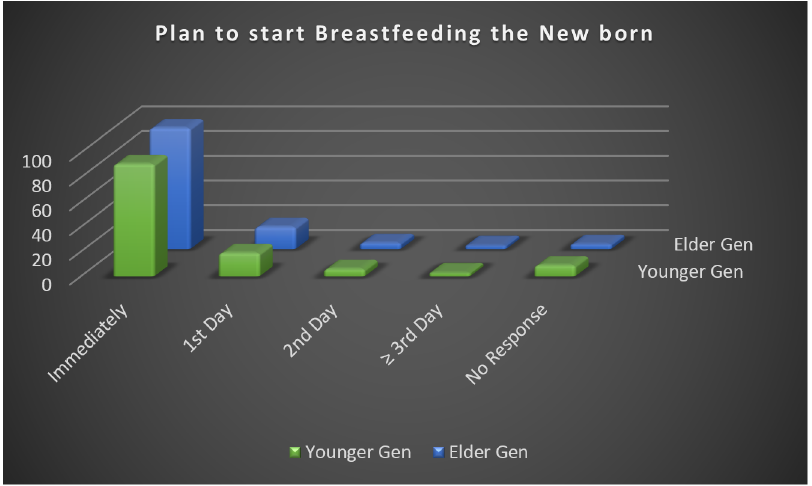
Fig 2. Responses obtained from the two groups when asked about the plan of time of initiating breast